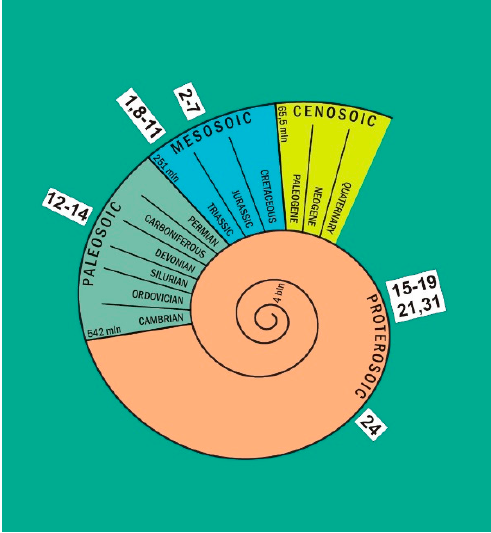
Figure 5. A simplified diagram of geologic time with numbers (in white fields) of specimens in the IGES Rock Garden according to their ages